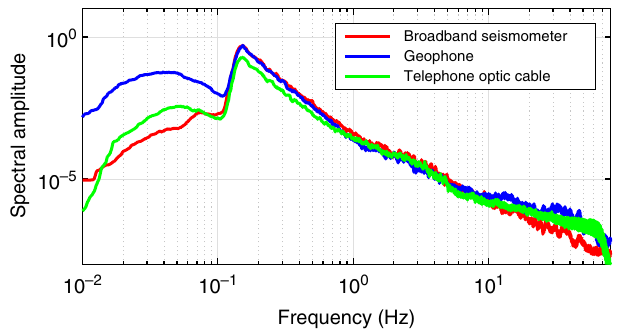
Fig. 4 DAS record conversion to seismic data. True amplitude spectra of displacements of 1 h (20.03.2015 5:00-06:00) noise record for DAS (green), geophone (natural frequency of 4.5 Hz, blue) and broadband ( fl at amplitude response between 0.008 and 100 Hz, red) records, respectively, after instrumental corrections (Methods: Instrumental correction of records from the iDAS system)